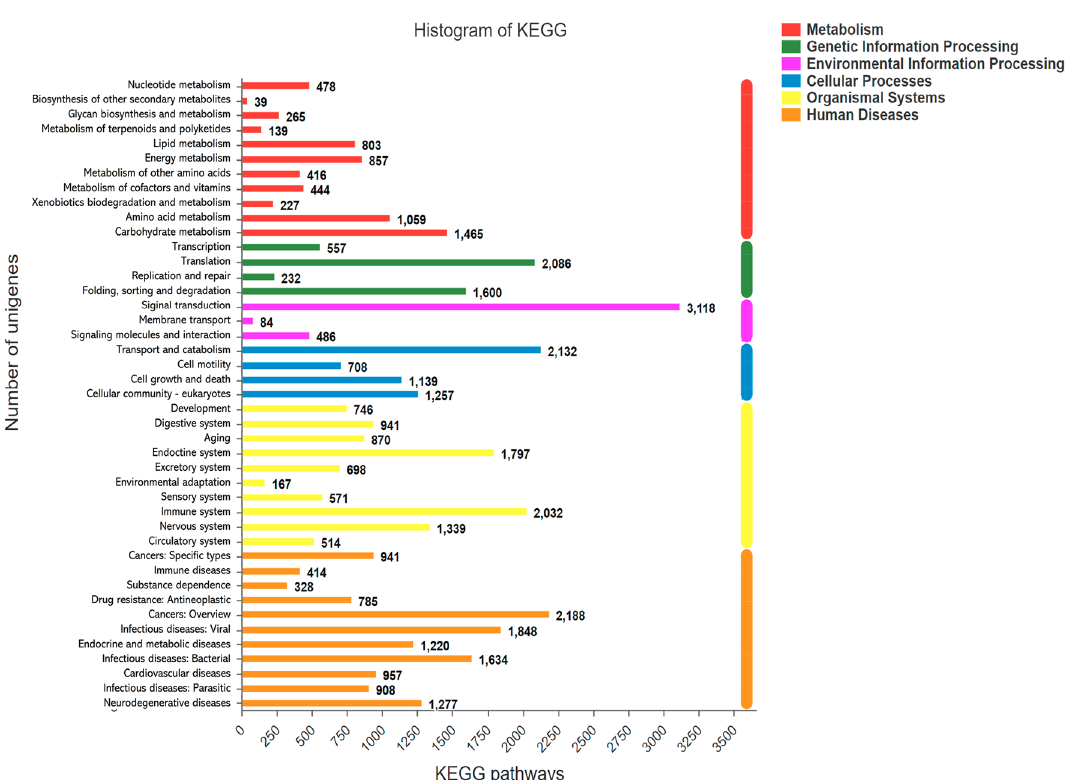
Figure 5. Mapping of KEGG pathway functions of transcripts in adult female spongy moth